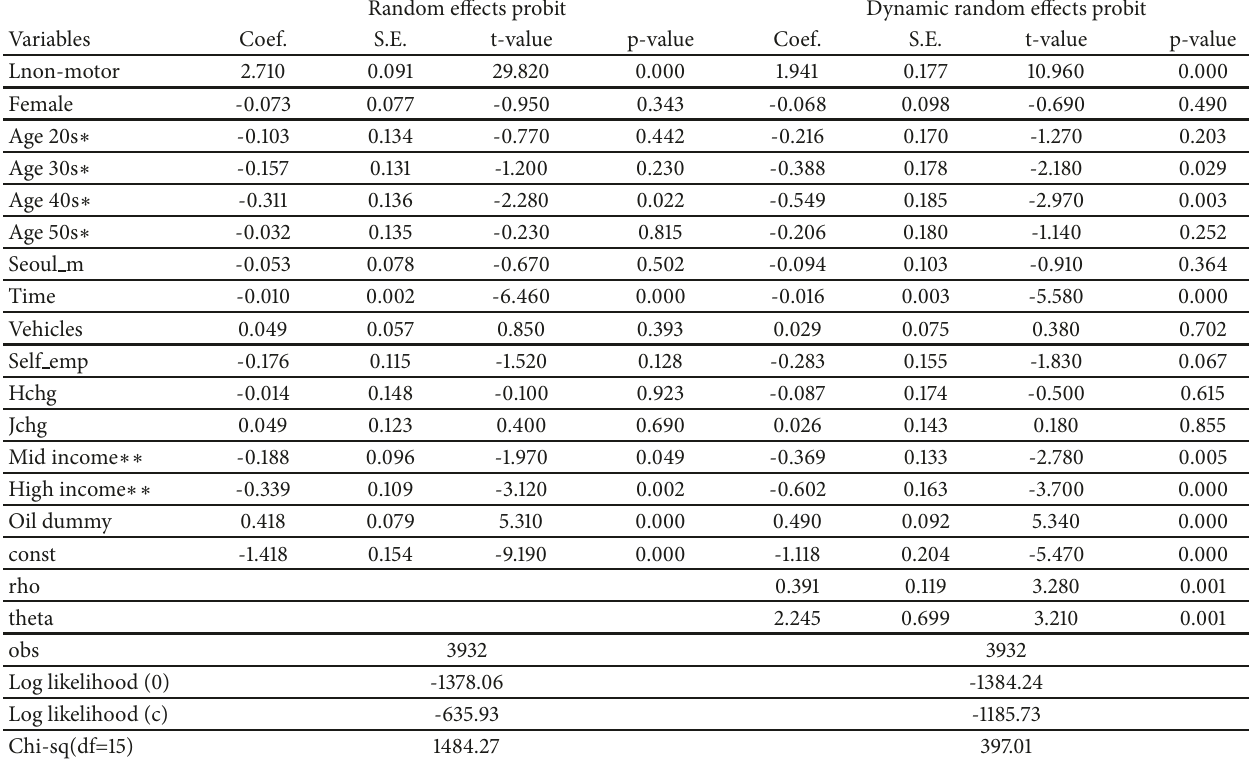
Table 8: Probit results of nonmotorized vehicle users.